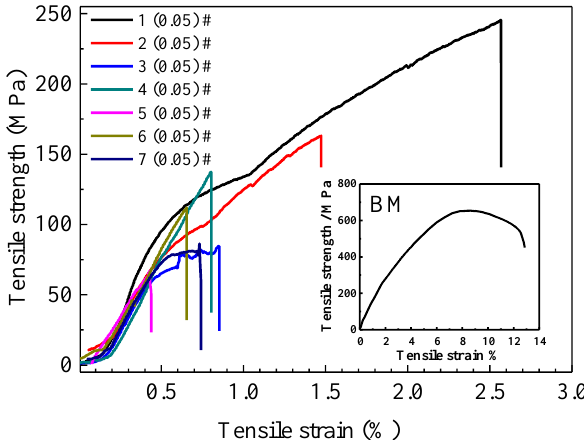
Figure 7. The stress – displacement curves of the Mo – Re welded joints with a thickness of 0.5 mm. joints obtained under different welding parameters also presented no significant difference. Table 6. Analysis results of the maximum tensile strengths of the Mo – Re welded joints with a thick- The average Vickers hardness of the different zones of the joints equaled 200 HV. ness of 0.5 mm, obtained through a three-factor and three-level orthogonal test.